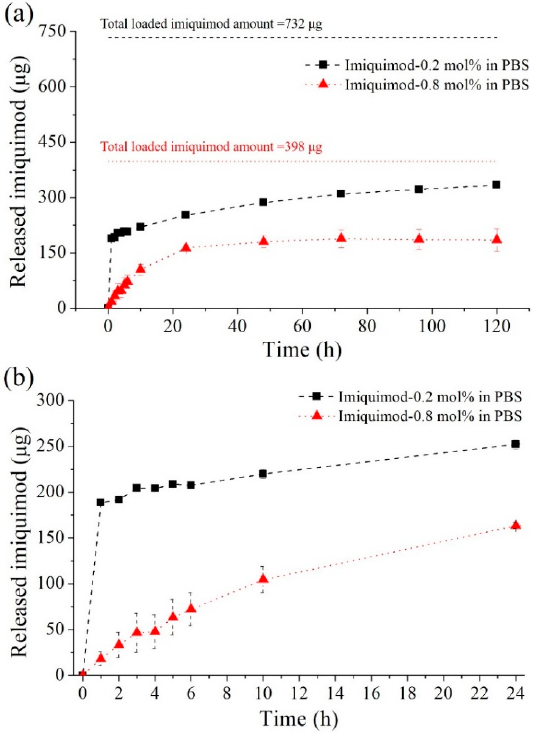
Figure 10. ( a ) The characterisation of imiquimod-release profiles from the samples of the imiquimod-poly(MEO 2 MA) hydrogel, crosslinked with 0.2 mol % and 0.8 mol % of DEGDMA in PBS solution at 37 °C. ( b ) The details of imiquimod-release profiles in the first 24 h.